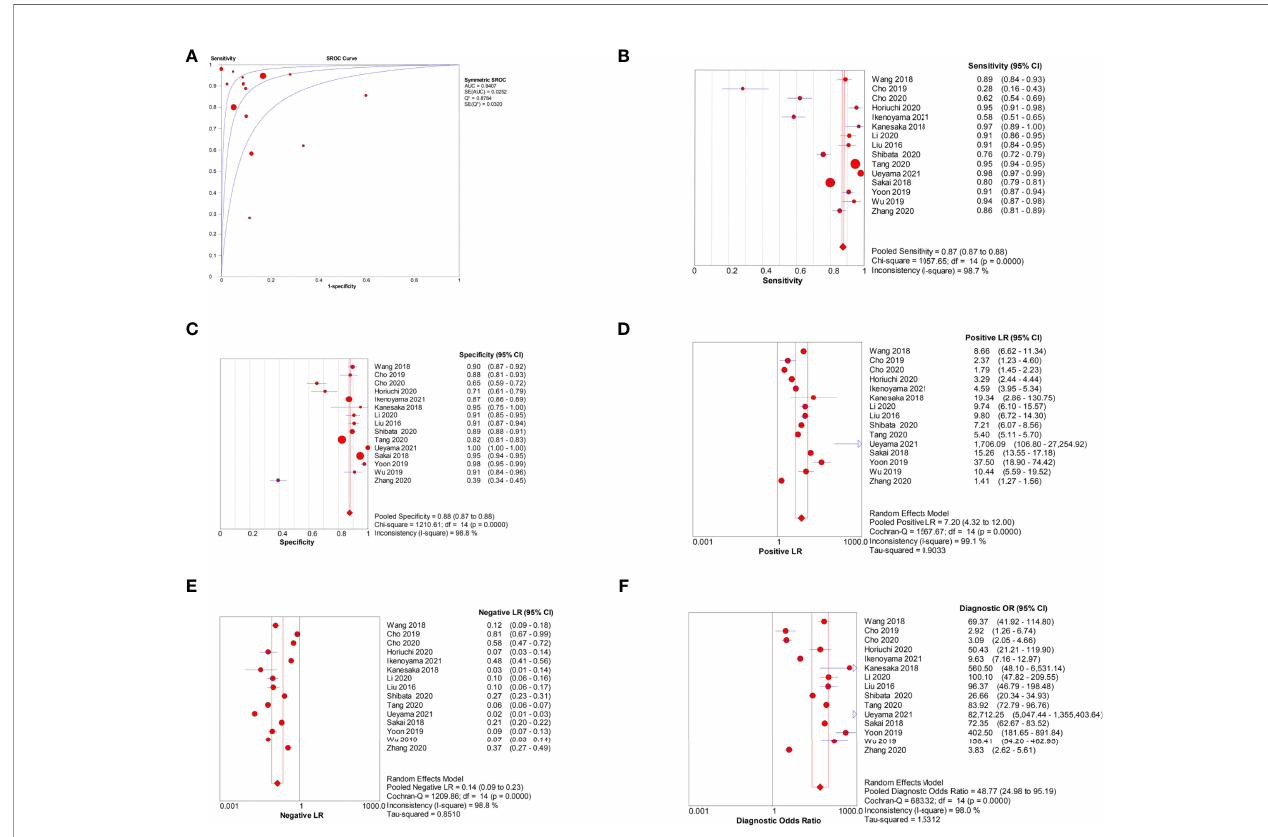
FIGURE 5 | Meta-analysis of AI-assisted EGC diagnosis (image-based analysis). (A) SROC curve. (B) Pooled sensitivity. (C) Pooled speci fi city. (D) Pooled PLR. (E) Pooled NLR. (F) Pooled DOR.